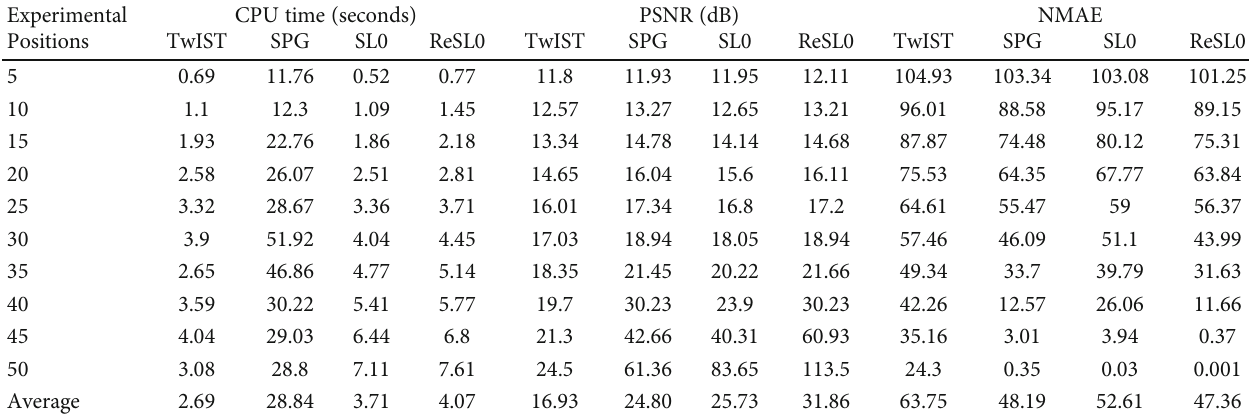
Table 1: Numerical results of reconstructed